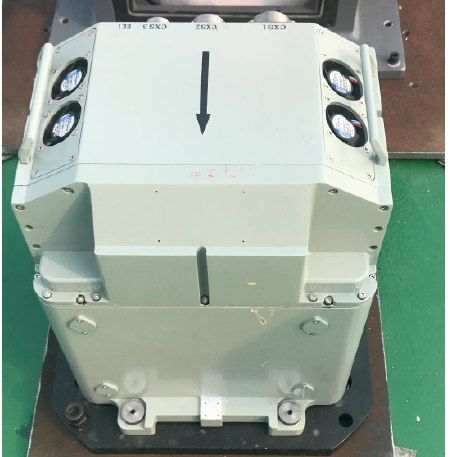
Table 1. GPS/INS unit attitude measurement accuracy.